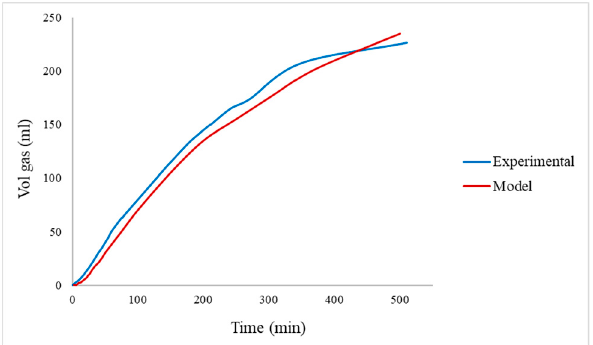
Figure 4. Volume of gas produced with respect to time. Reaction conditions: temperature = 30 °C; pressure = 1 bar; inlet flow = 0.05 mL/min; 0.1 g catalyst of 5 wt.% Pd on Carbon.